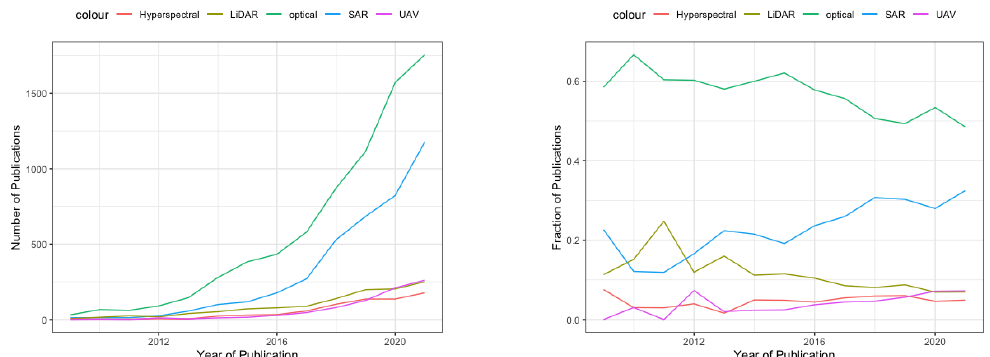
Figure 5. Number of articles published in Remote Sensing using a given sensor ( left ) and fraction of articles published in Remote Sensing using a given sensor ( right